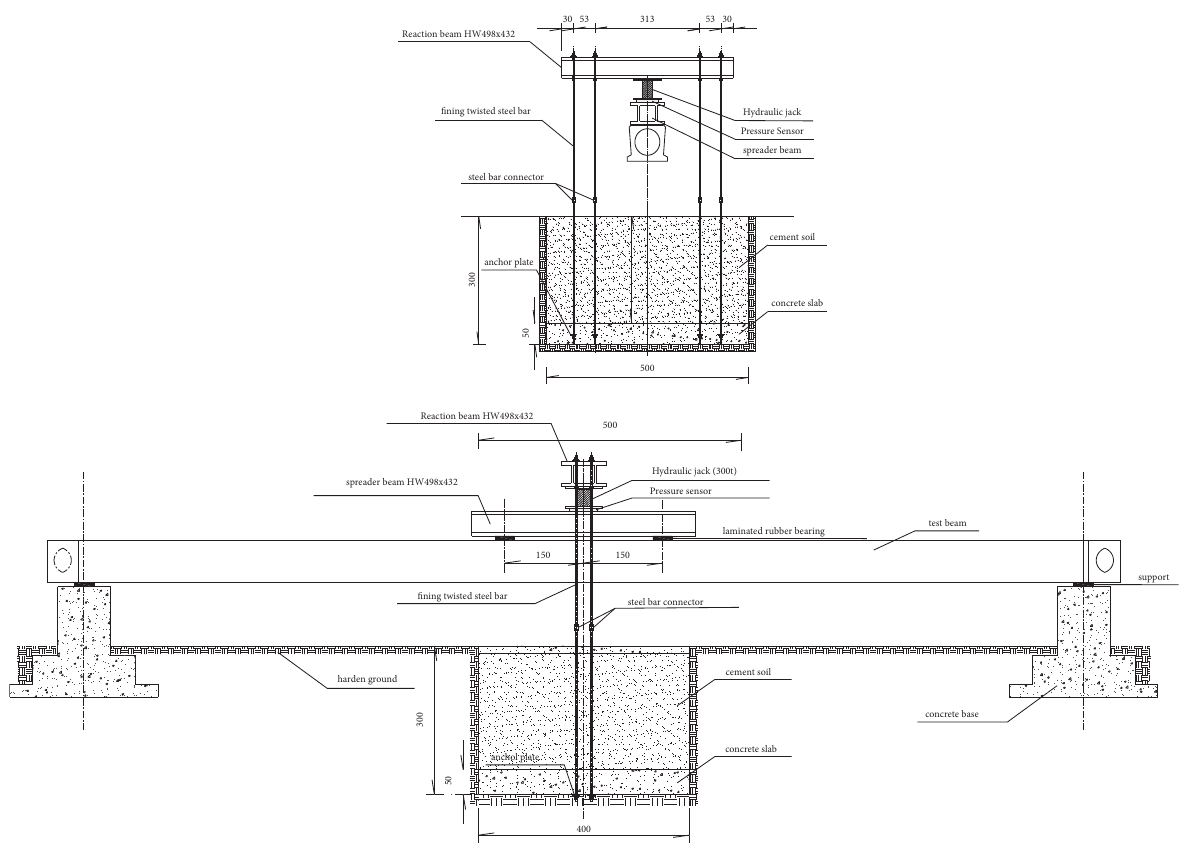
Figure 3: The loading arrangement (unit: